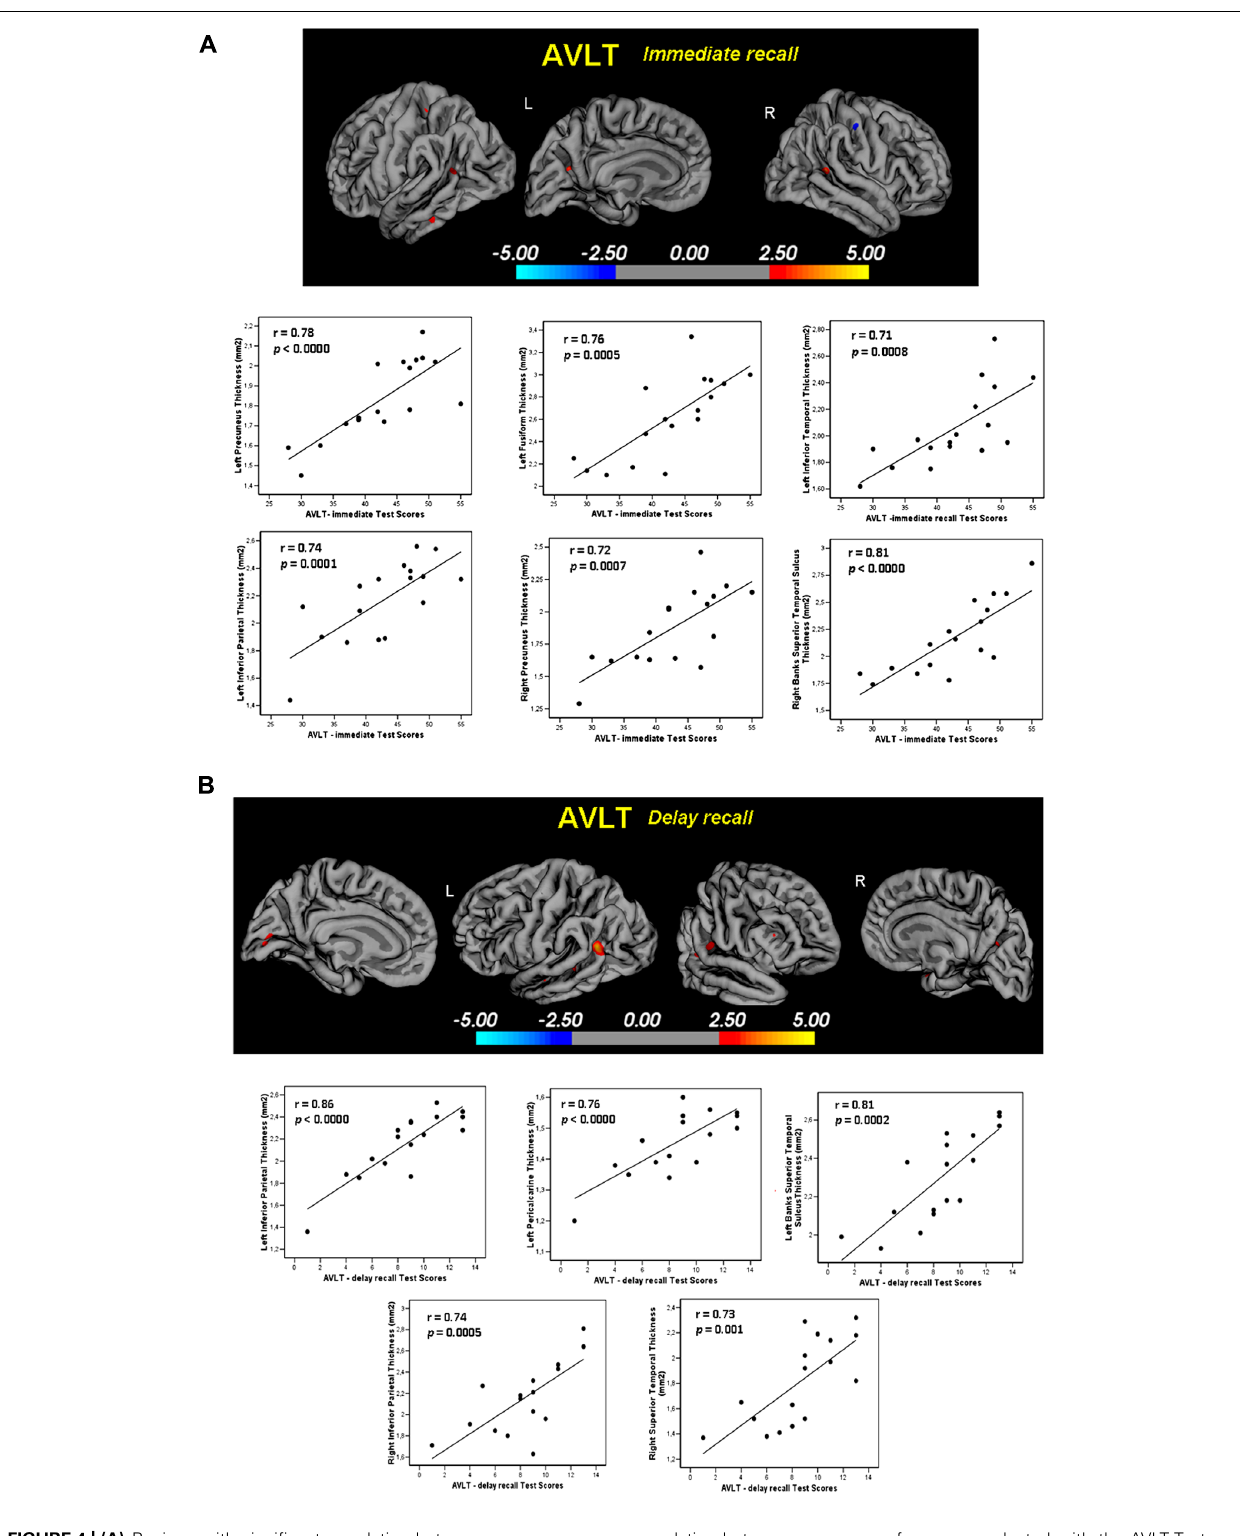
FIGURE 4 | (A) Regions with significant correlation between memory performance evaluated with the AVLT Test- immediate recall- and cortical thickness measure in the High a3/a2 group. r and p denote the correlation coefficient and significance level respectively. (B) Regions with significant